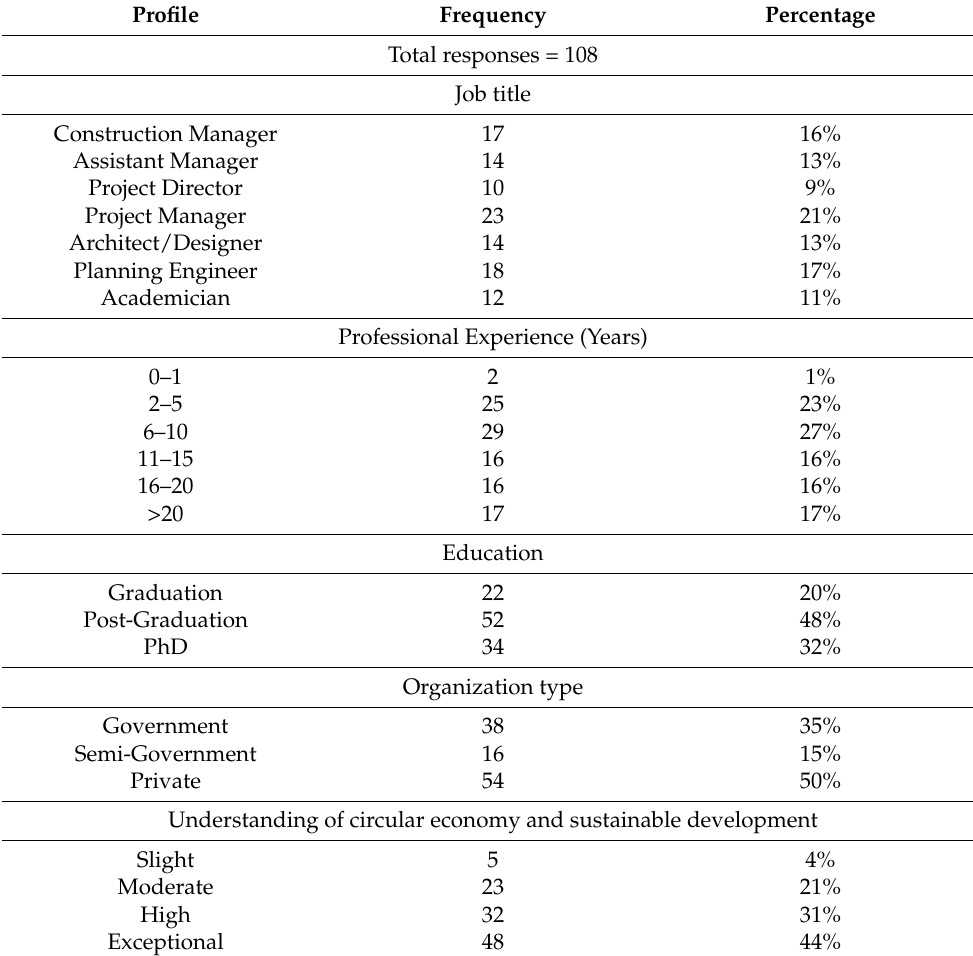
Table 2. Demographic details of respondents.